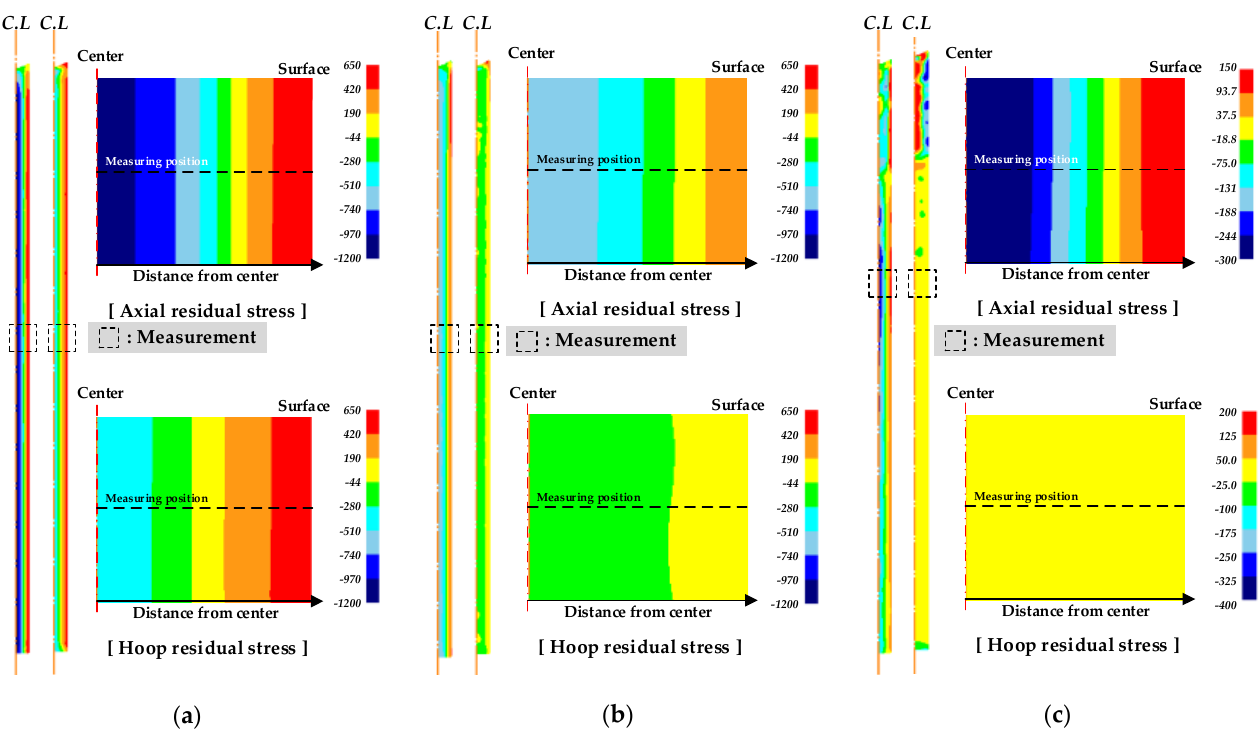
Figure 6. Measurement of axial and hoop residual stresses from the FE results for drawing process: ( a ) single, ( b ) double (Case 5), and ( c ) triple dies (Case 9).